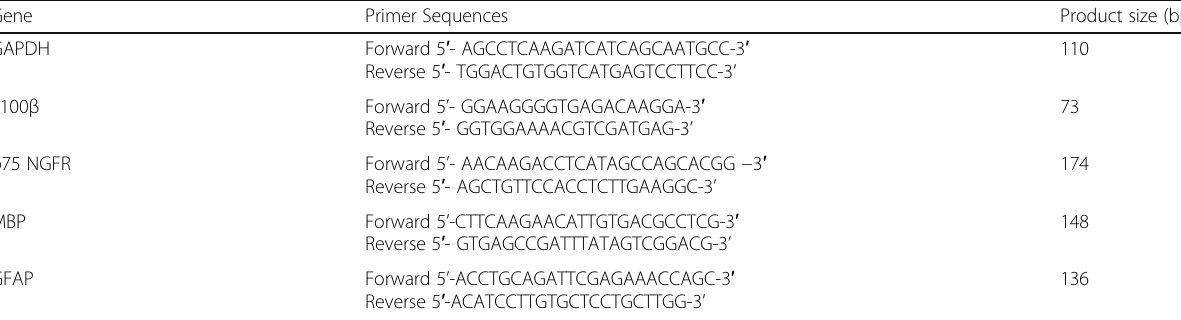
Table 1 The primer pairs used in the qPCR assay and amplicon sizes Gene Primer